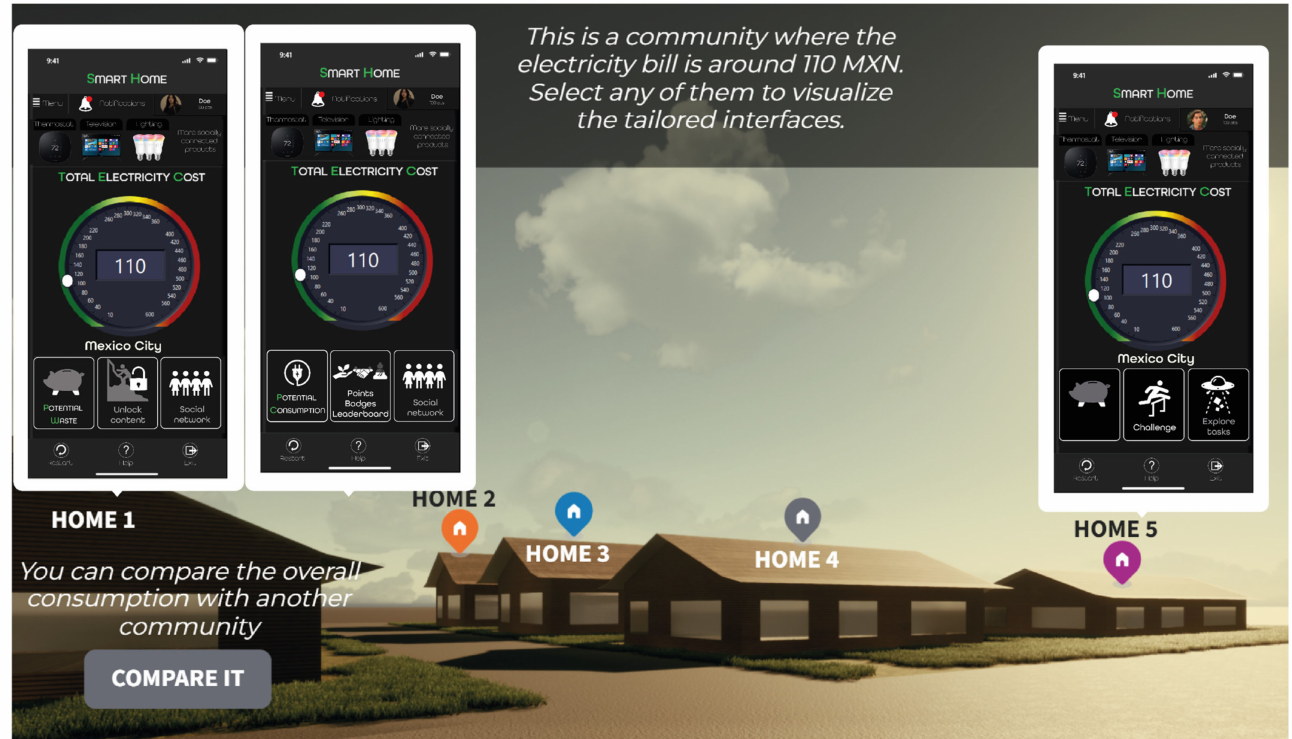
Figure 4. Conceptualization of a gamified